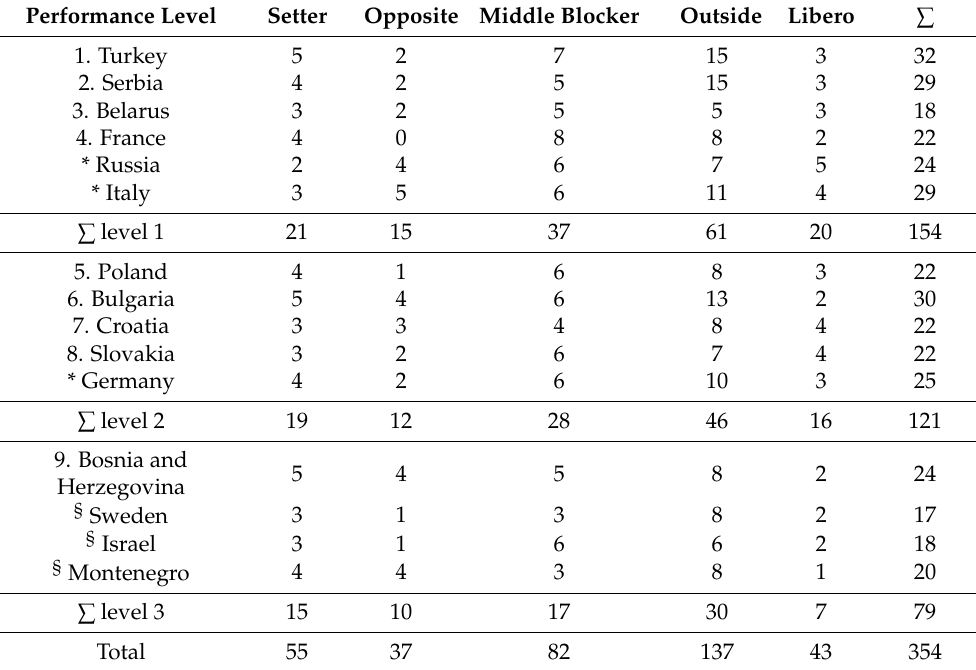
Table 1. Number of players in each position and each team, analyzed according to the CEV U19 Volleyball European Championship 2020